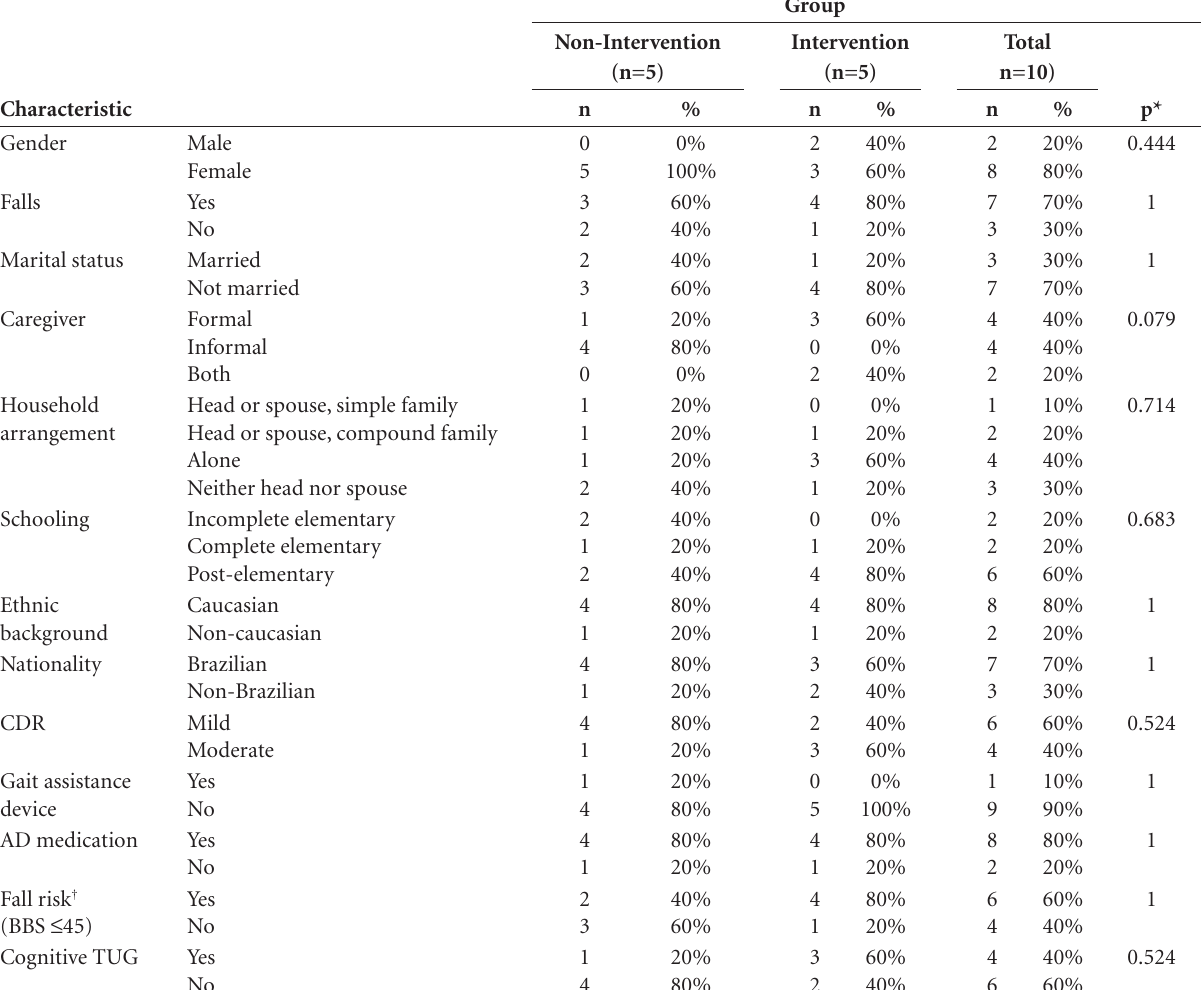
Table 1. Summary statistics of categorical variables for intervention and non-intervention groups at